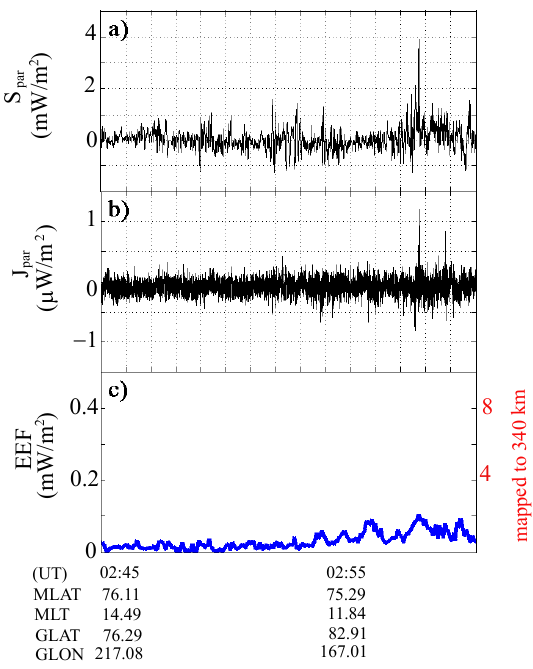
Figure 13. Cluster 3 on 9 June 2008: (a) parallel Poynting flux, (b) parallel current density, (c) electron energy fluxes, where blue colour indicates Earthward direction. Right axis shows EEF mapped to